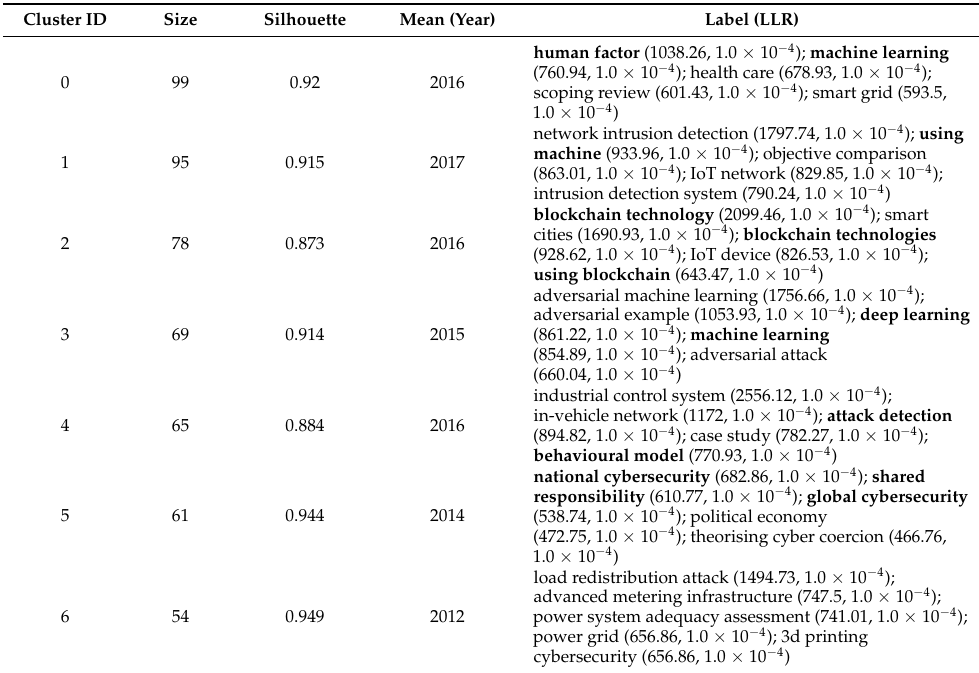
Table 6. Clusters of cybersecurity are labelled by major research